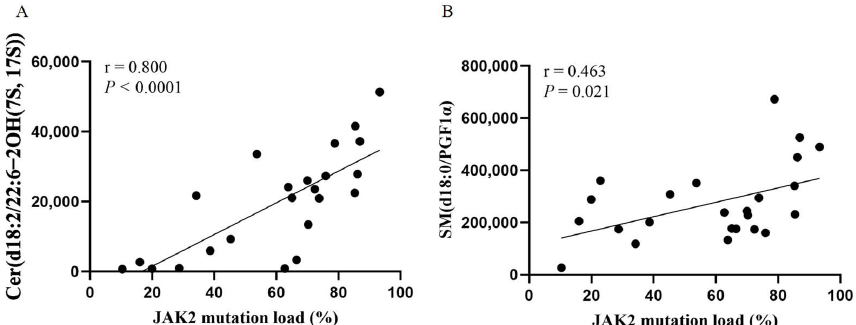
Figure 5. Scatter plot of the correlation between Cer(d18:2/22:6-2OH(7S, 17S)) ( A ) and SM(d18:0/PGF1 α ) ( B ) levels and JAK2 mutational burden. Spearman’s correlation test.